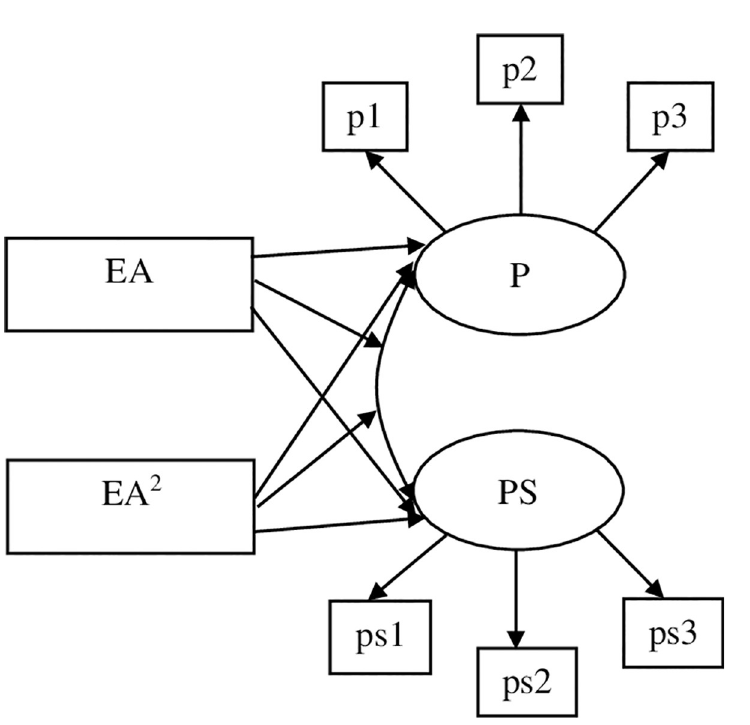
Fig 3. The conceptual diagram for the test of the linear and quadratic moderating effects of early adversity on the covariance between adulthood perceived stress and personality traits. P = personality traits; PS = adulthood perceived stress; EA = early adversity; p1-p3 represents manifest indicators of personality; ps1-ps3 represents manifest indicators of perceived stress.